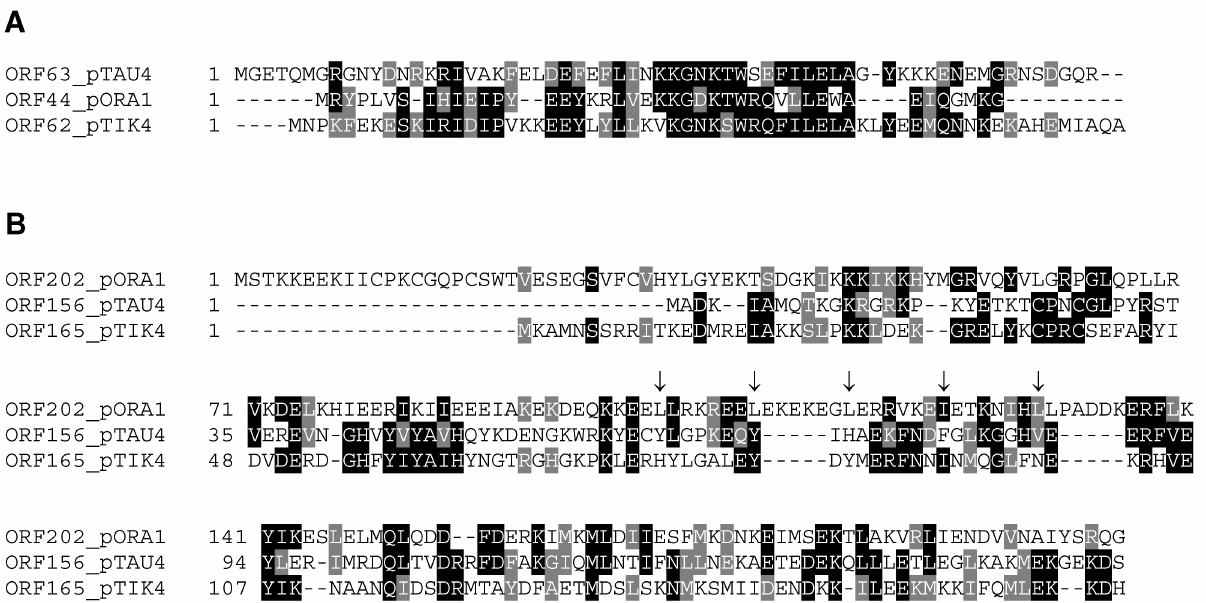
Figure 4. Alignment of the amino acid sequences of (A) the CopG homologs from the three S. neozealandicus plasmids and (B) homologs ORF202, ORF156 and ORF165, which are specific for the S. neozealandicus plasmids. The ORF202 of pORA1 carries a putative N-terminal sig- nal peptide and a leucine zipper motifmarked by arrows. Identicaland similaramino acids are indicated by black and gray boxes, respectively, ob- tained with Boxshade (see Figure 2).